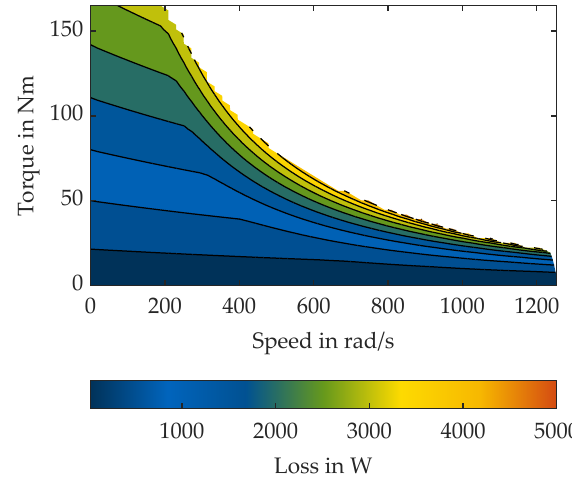
Figure A2. Contour lines of th IMs electric motor